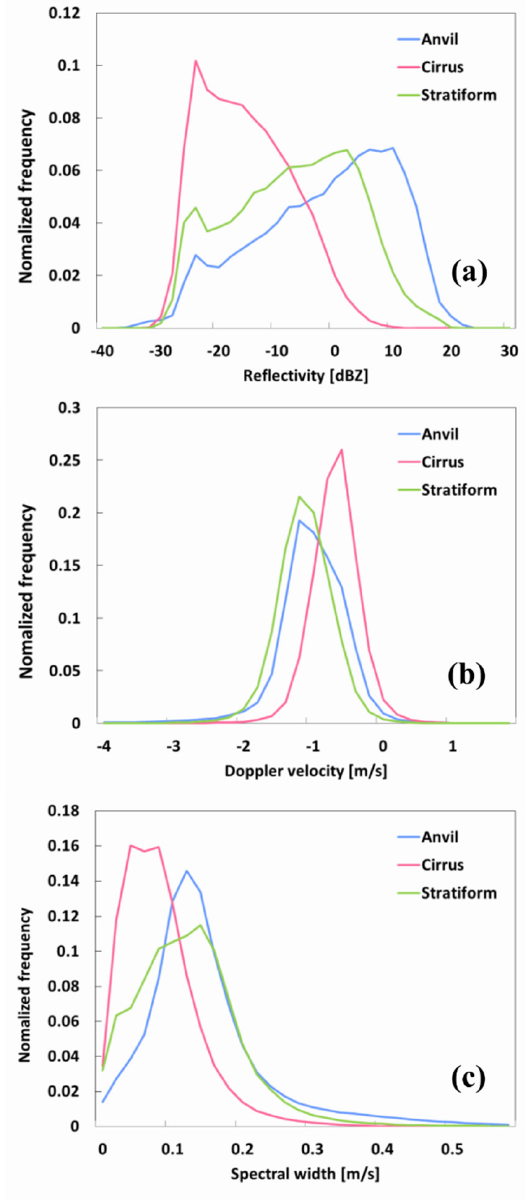
Figure 4. Histograms of ( a ) Z , ( b ) V D , and ( c ) SW by ice cloud type (blue: anvil, pink: cirrus, and green: stratiform).